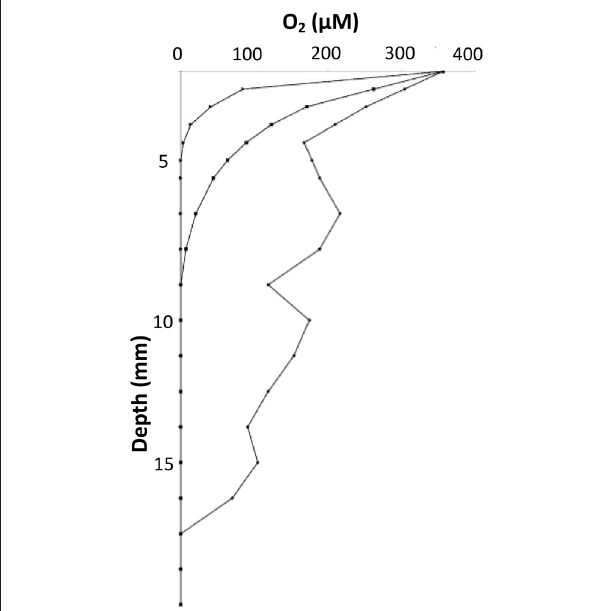
FIGURE 8 | CO 2 and O 2 concentration profiles with depth at 24h ( (cid:7) ) and 48h ( (cid:4) ) after inoculation with Lactobacillus paracasei CI3 in MRS 0.1% agar. A MIMS (membrane inlet mass spectrometric) probe was inserted through column of growth. Adapted from Tammam et al. (2001).